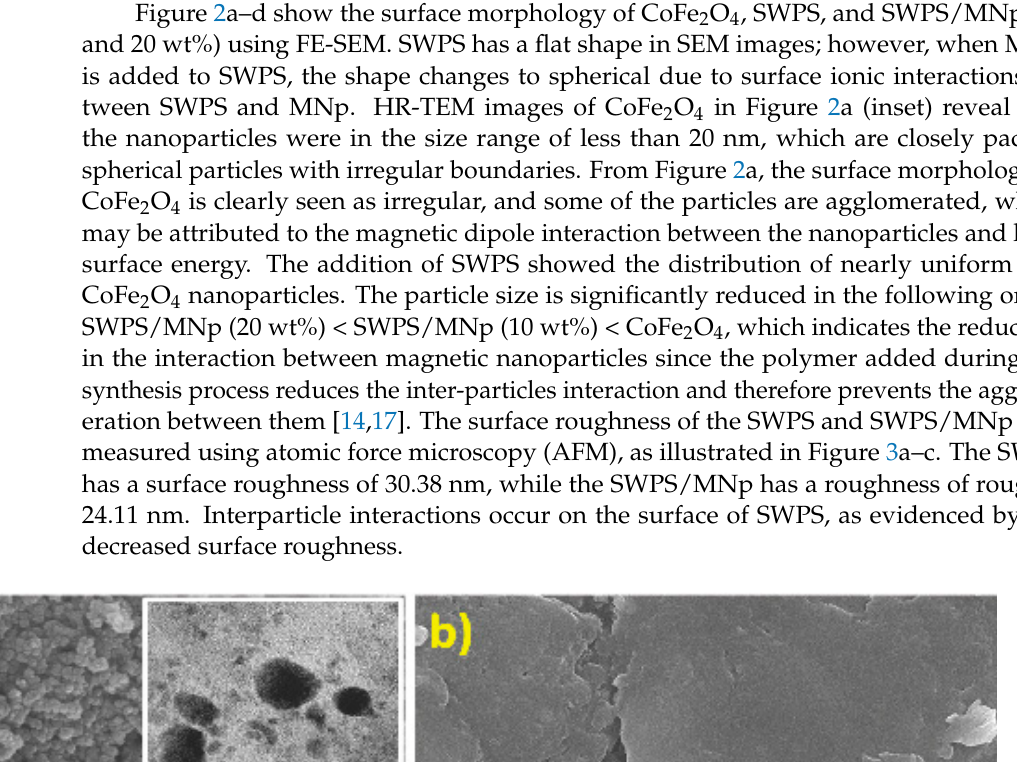
Figure 2. FE − SEM images of ( a ) CoFe 2 O 4 (Inset shows TEM image), ( b ) SWPS, ( c ) SWPS/MNp (10 wt%) and ( d ) SWPS/MNp (20 wt%). Figure 3. AFM images of ( a ) SWPS, ( b ) SWPS/MNp (10 wt%) and ( c ) SWPS/MNp (20 wt%).